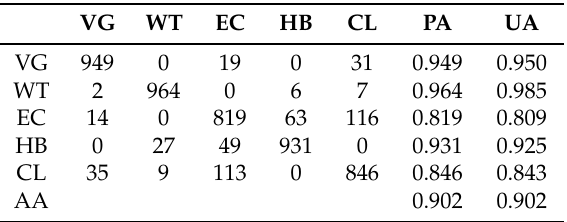
Table 19. Confusion matrix of the RFs in the first